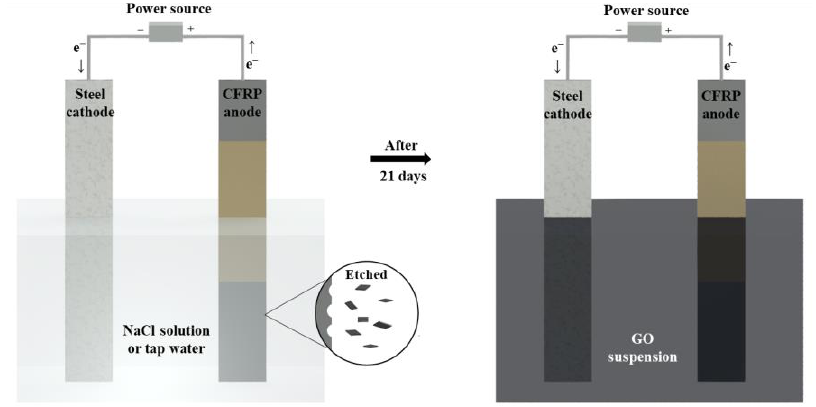
Figure 2. Scheme of recycling nanoarchitectonics of GO by electrochemical method.